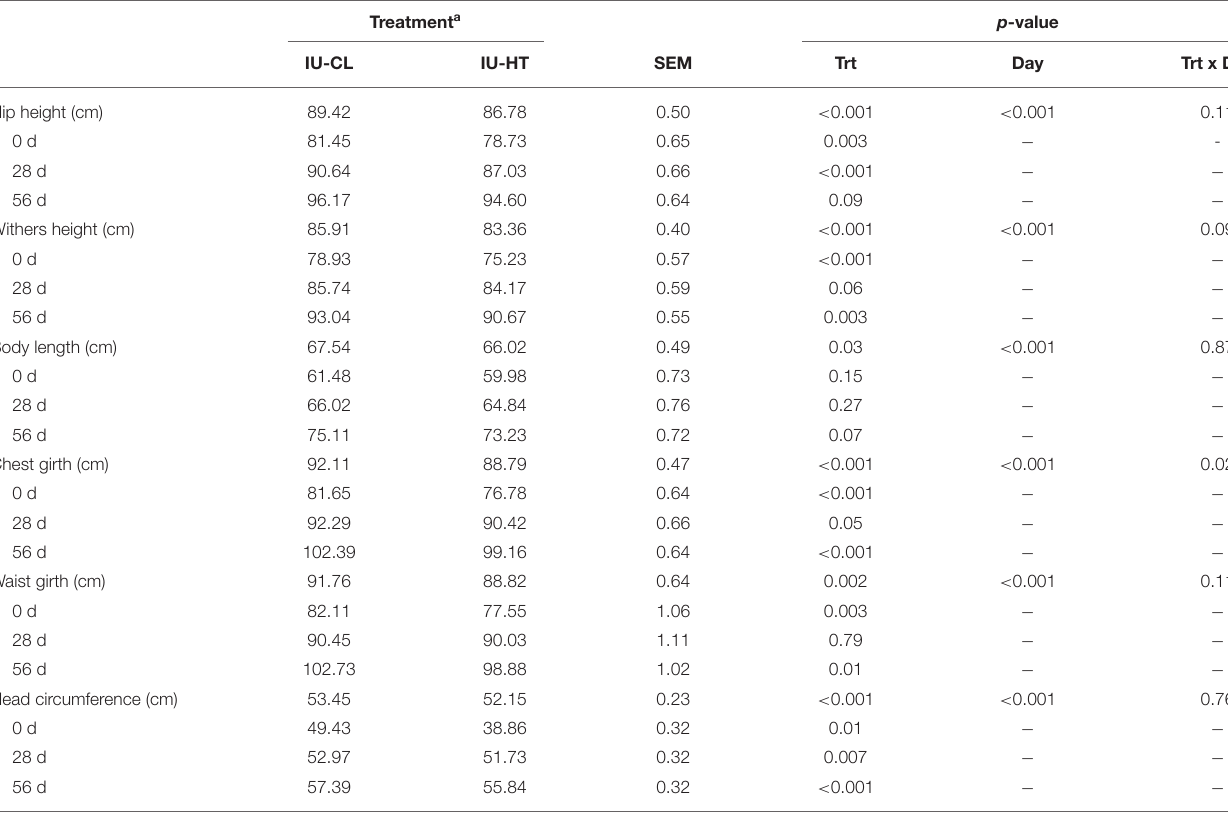
TABLE 2 | Growth and stature parameters of dairy heifers exposed to late gestation in utero heat stress (IU-HT) or cooling (IU-CL) measured at 0, 28, and 56 d of age. Treatment a p -value IU-CL IU-HT SEM Trt Trt x Day Hip height (cm)